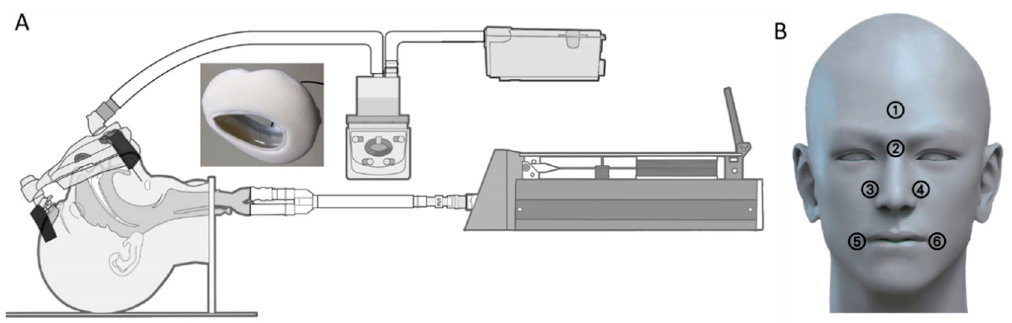
Figure 2. ( A ) Diagram of the experiment apparatus, ( B ) pressure measurement points.